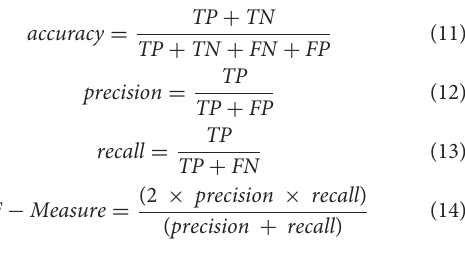
(FN), recall, accuracy, specificity, G-mean, precision, F- measure, and MCC. Equations (11–17) (44–46) depict these evaluation measurements.